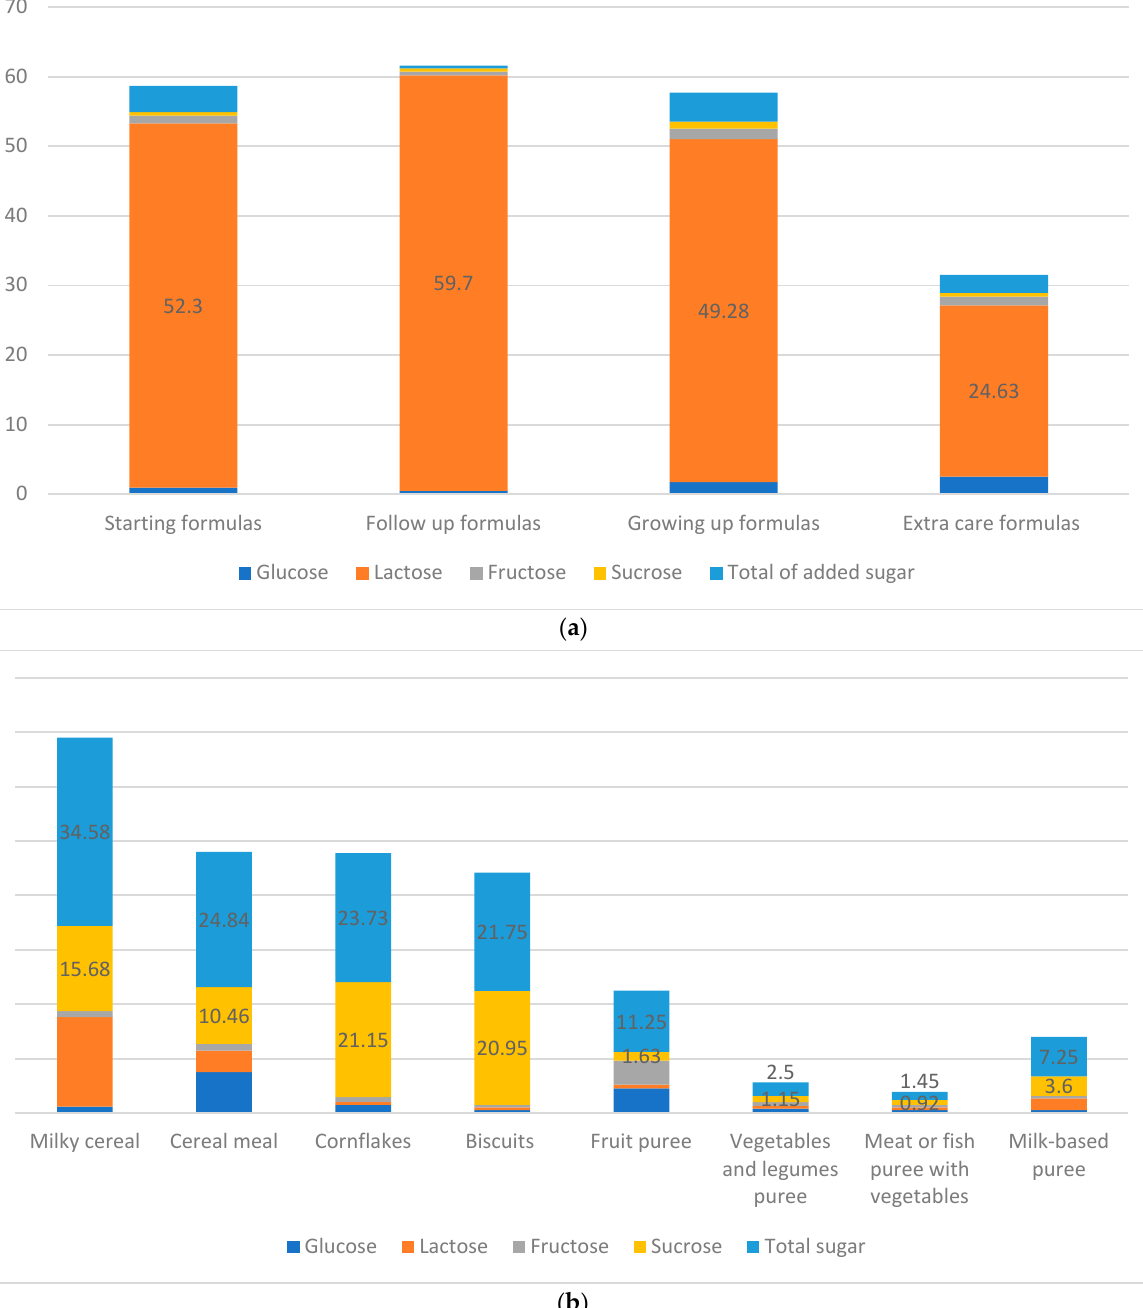
Figure 3. ( a ) Percentage of lactose and added sugar distribution in 100 g of infant formulas: starting formulas (0–6 months); follow-up formulas (6–12 months); growing-up formulas (1–3 years), and extra-care formulas (0–12 years). ( b ) Percentage of added sugar distribution in 100 g of baby food products that targeted children aged 6 months and plus.